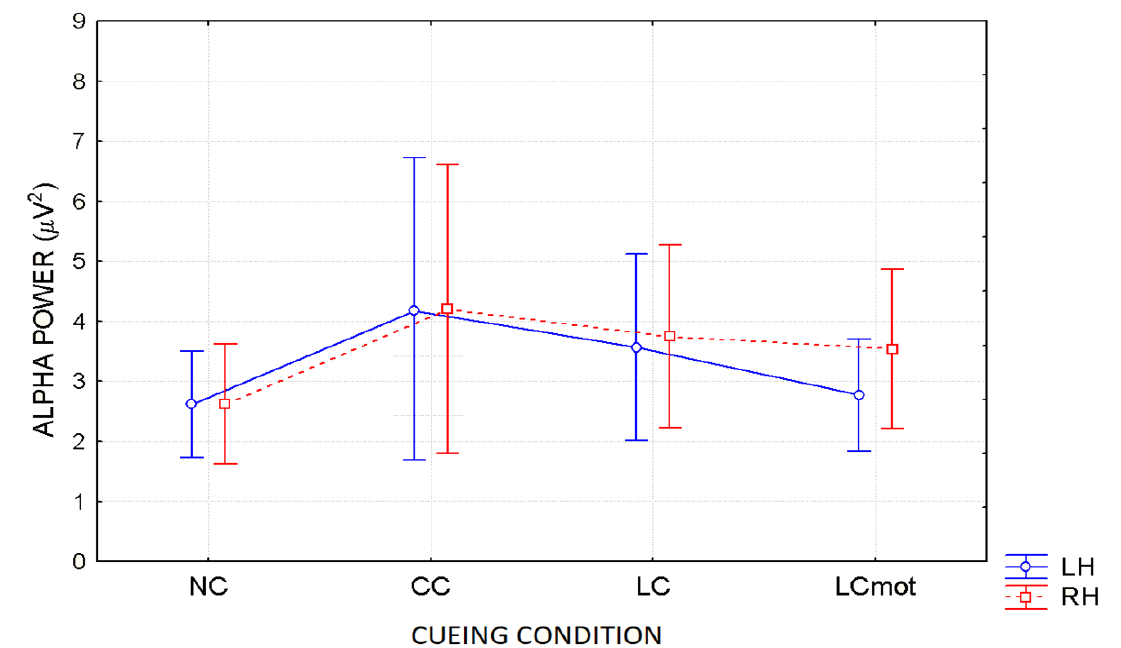
Figure 6. Mean and SE values of alpha power (in µ V 2 ) as a function of cueing conditions and hemispheres collapsed across respiratory conditions. Note that for an easier readability, alpha power values were multiplied by 10 before being plotted.